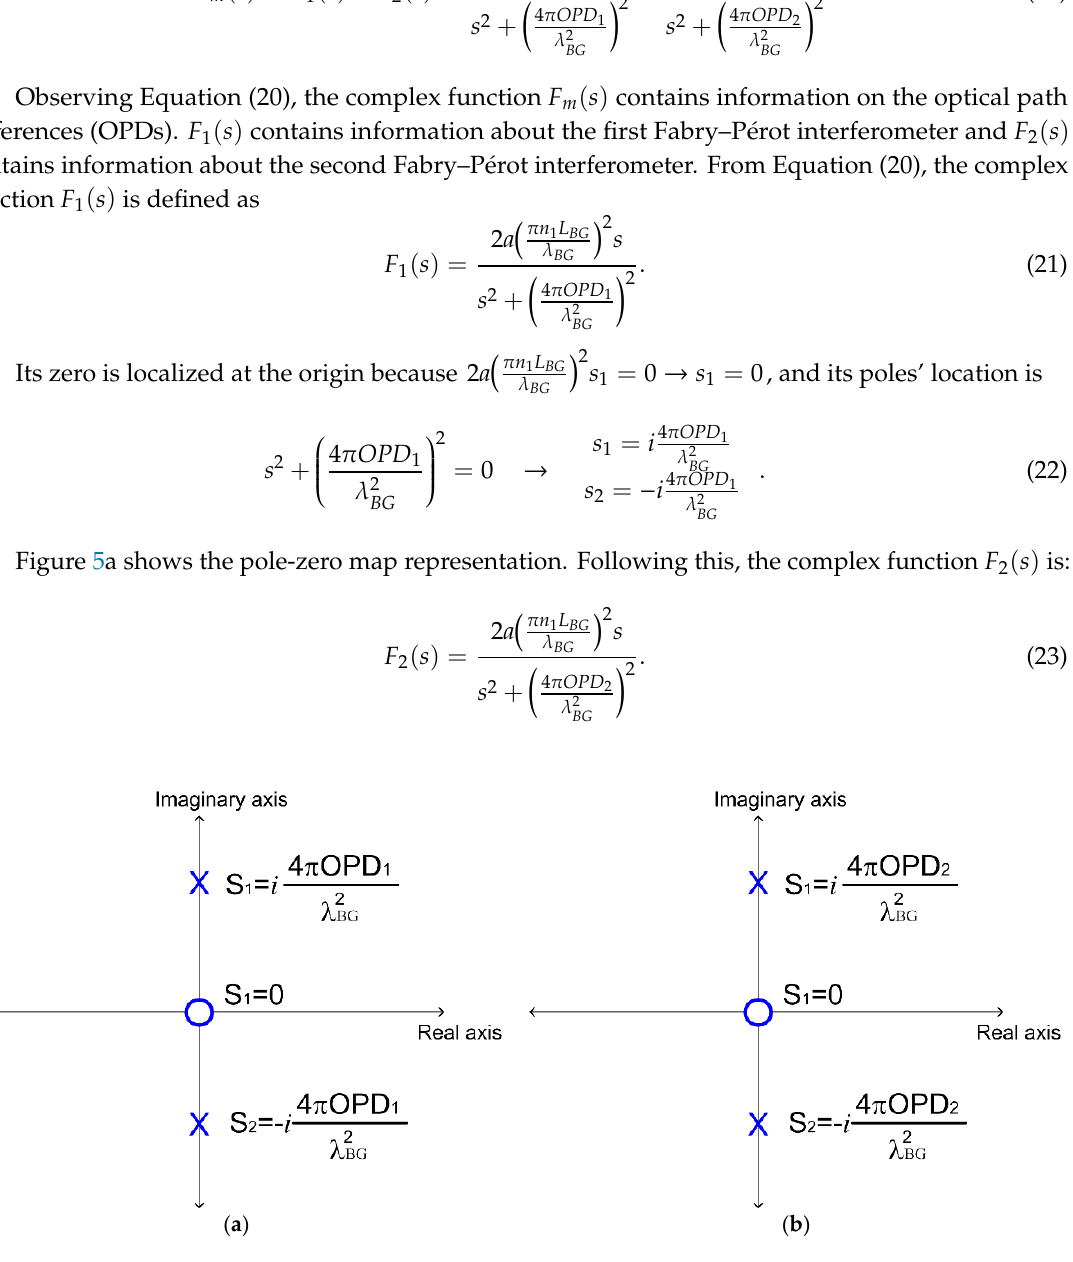
Figure 5. Pole-zero map obtained for the complex function 𝐹 𝑚 (𝑠) : ( a ) the complex function 𝐹 1 (𝑠) ; ( b ) the complex function 𝐹 2 (𝑠) . ( b ) the complex function F 2 ( s )